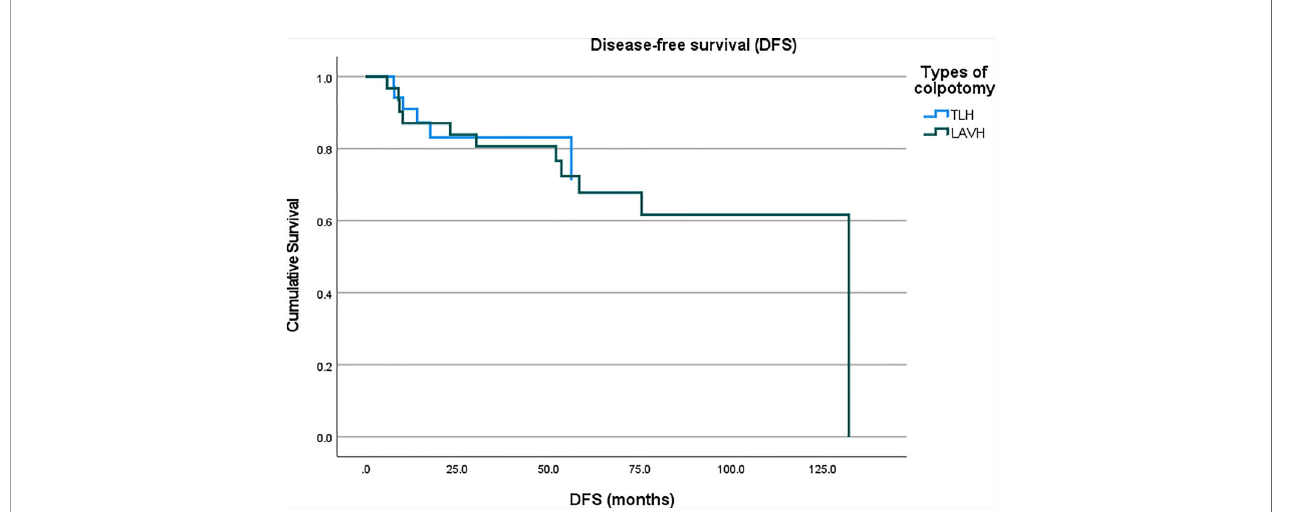
FIGURE 4 | Comparison of disease-free survival of the patients with endometrial cancer who underwent intracorporeal colpotomy (TLH, total laparoscopic hysterectomy) vs . transvaginal colpotomy (LAVH, laparoscopy-assisted vaginal hysterectomy).